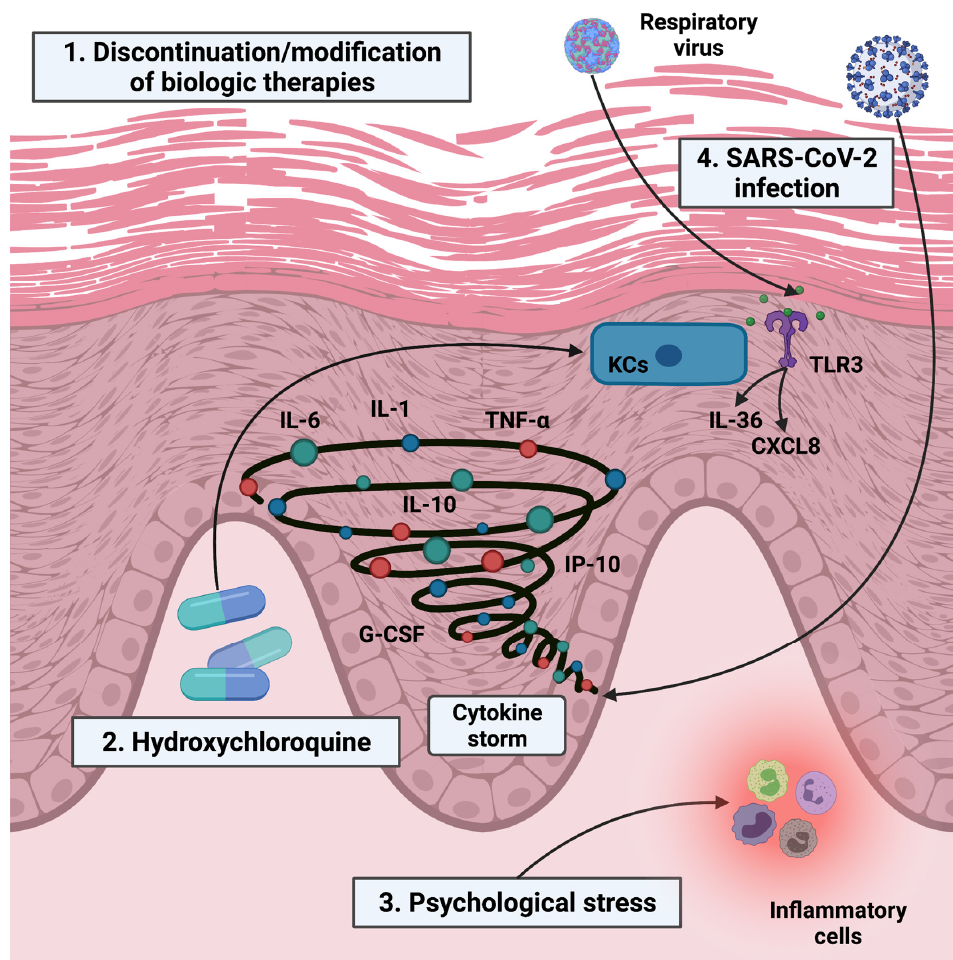
Figure 1. Possible pathogenetic mechanisms at the basis of psoriasis exacerbation. Created with BioRender.com. (Novem- ber 9th, 2021) 1. Discontinuation or modification (lengthening of the dosing interval) of biologic therapies. 2.